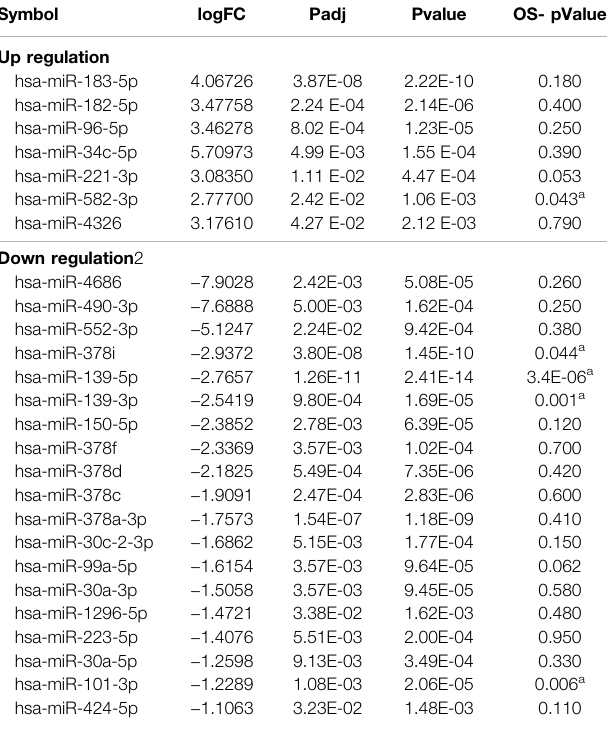
TABLE 2 | Differentially expressed miRNAs in adjacent tissue and hepatocellular carcinoma tissues. Symbol logFC Padj Pvalue OS-